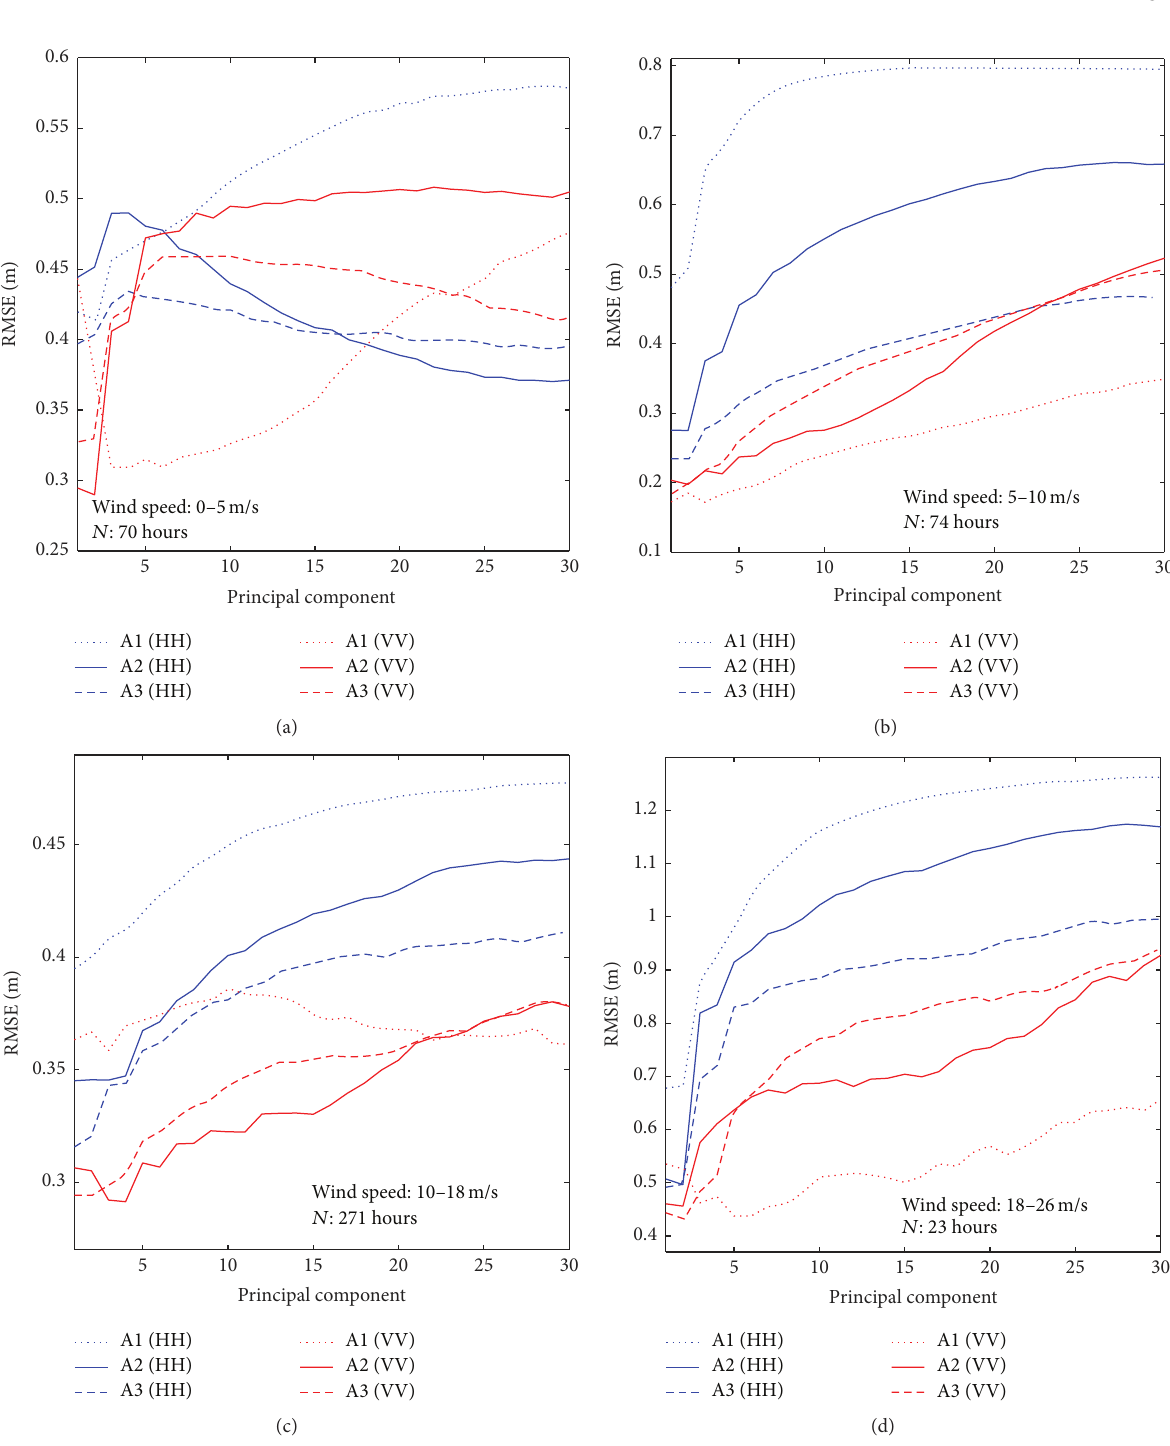
from X-band marine radars are shown in Figure 7. It indicates very different for HH and VV